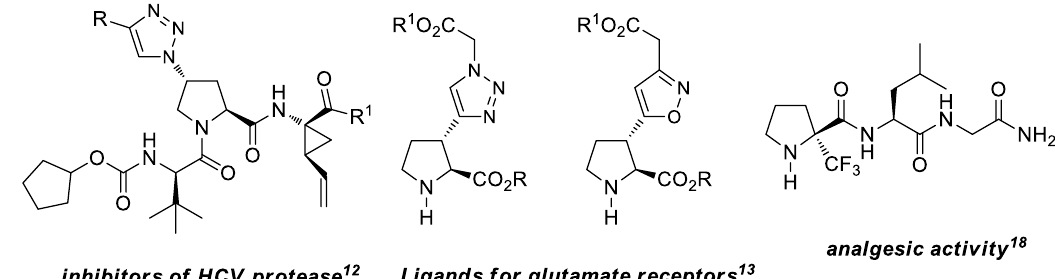
Figure 1. Selected examples of bioactive functionalized prolines.